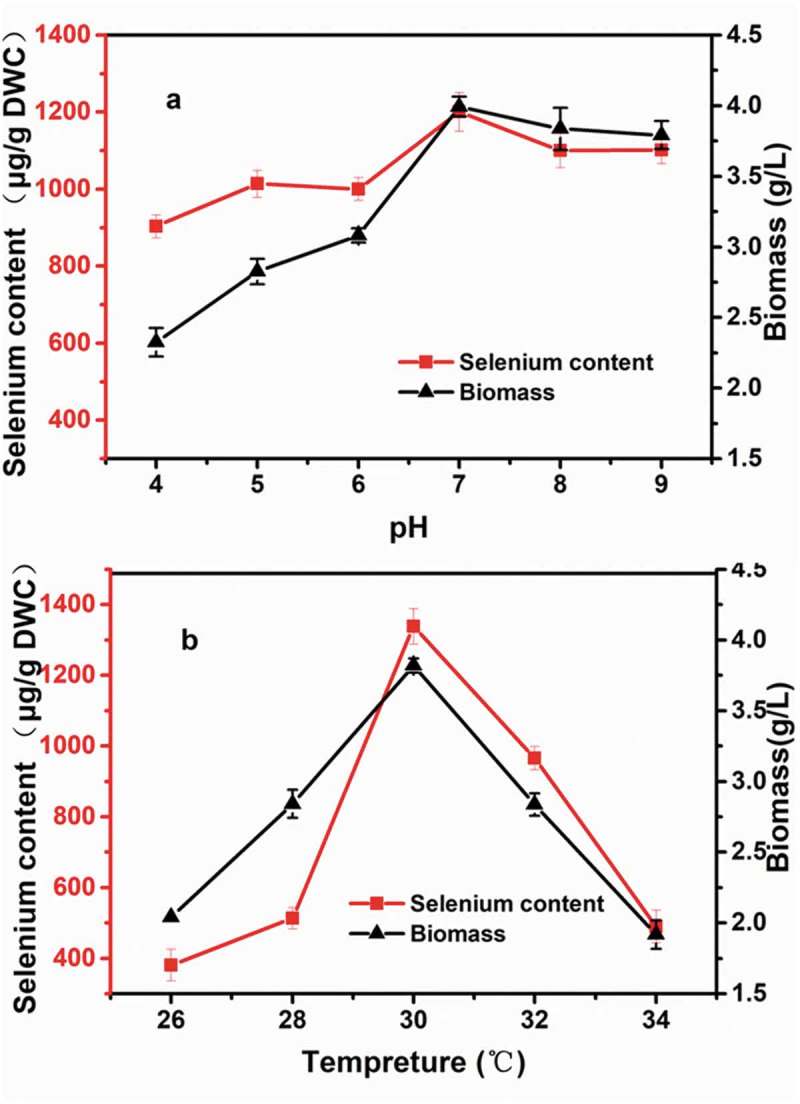
Influence of pH (a) and temperature (b) on the biomass and selenium content of R. glutinis X-20.